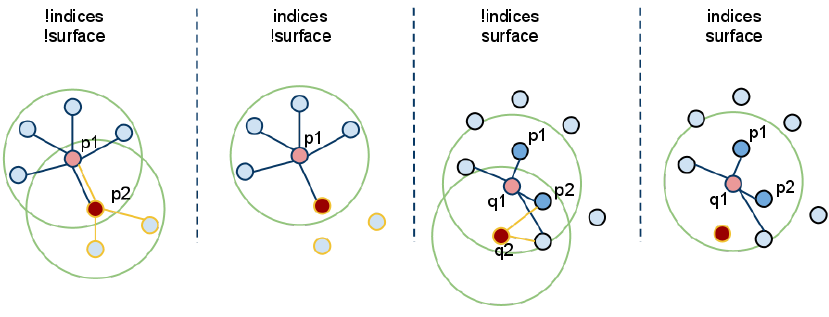
Figure 6. A visualization of the Euclidean cluster extraction [53].